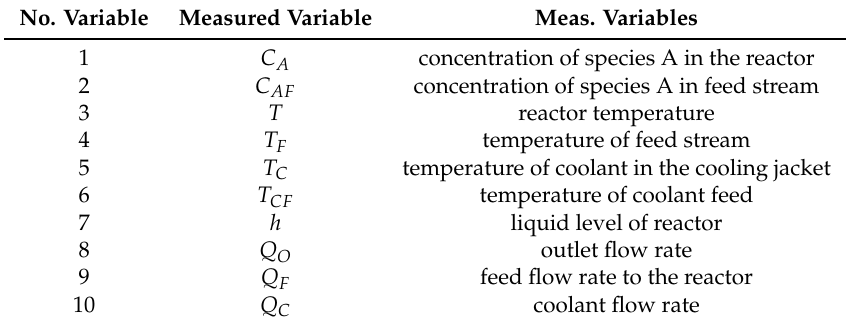
Table 2. Monitoring Variable in the CSTR Process.